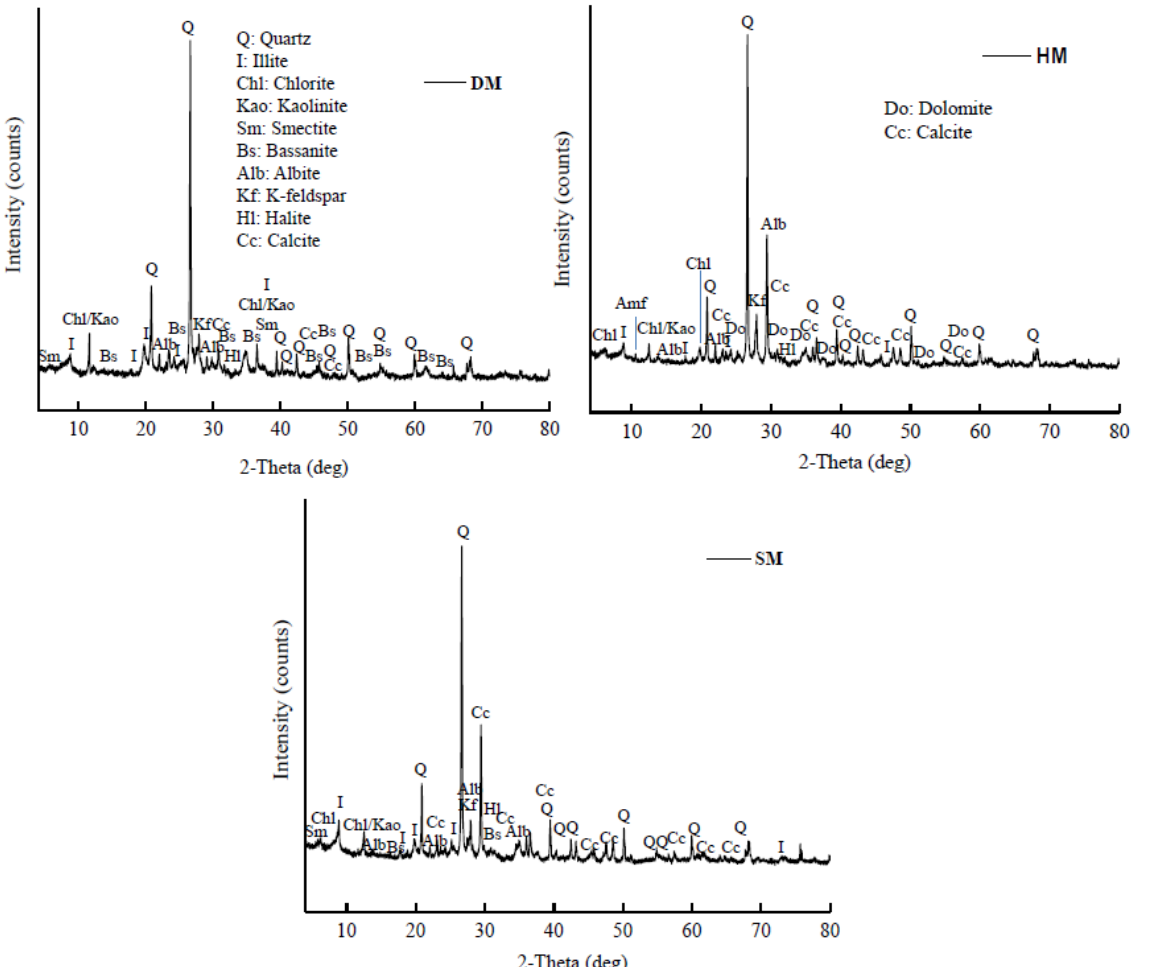
Figure 1. XRD spectrum of the glycolated DM, HM, and SM clays. Table 1. Granulometric analysis by sieving and carbonate test results.